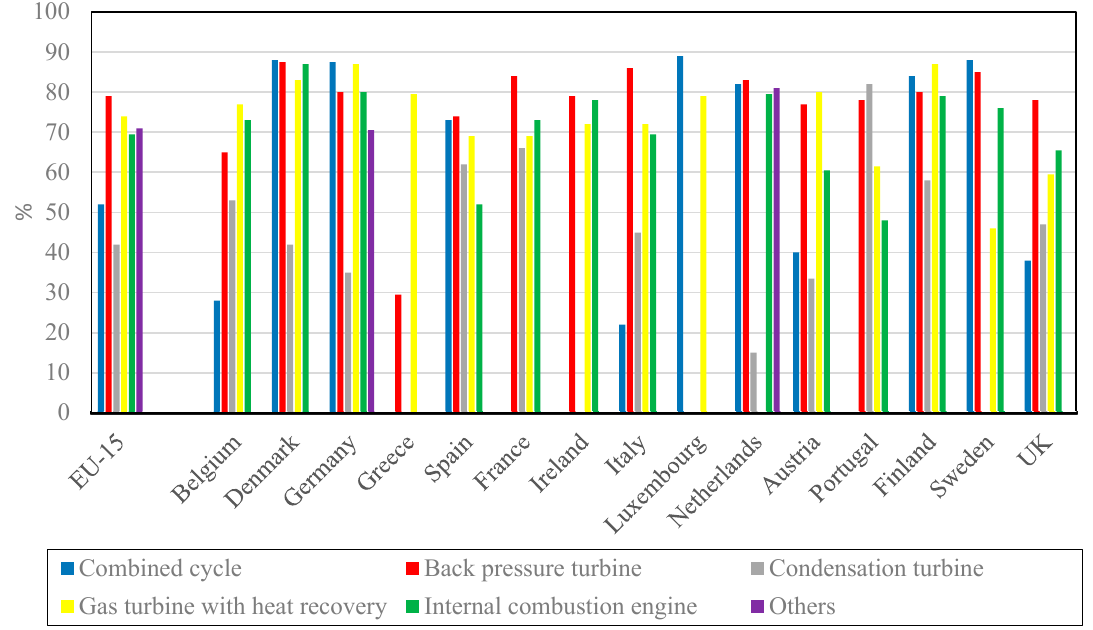
Figure 8. First law efficiency of different CHP systems in EU [31].